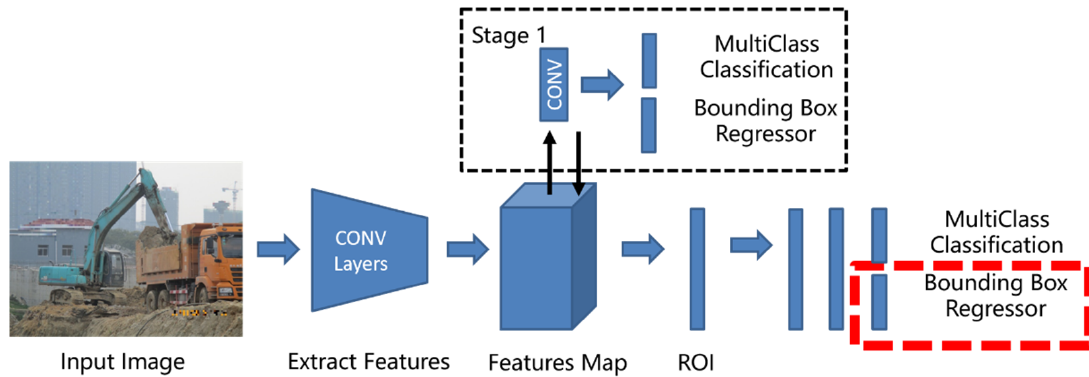
Figure 2. Network architecture of a one-stage detector.